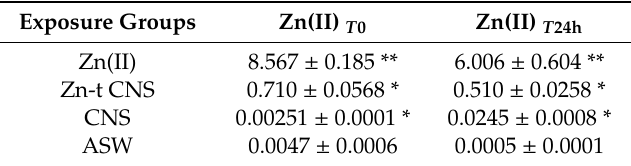
Table 1. Zn(II) concentration (mg L − 1 ) in mussels’ exposure waters at time zero ( T 0 ) (soon after preparation) and after 24 h ( T 24h ) of the following experimental groups: Zn(II) (ZnCl 2 10 mg L − 1 in ASW); Zn-t CNS (ZnCl 2 10 mg L − 1 contaminated ASW treated with CNS), CNS (ASW treated with CNS only); ASW (control). Results are reported as mean ± SD. (*) indicates significant di ff erences with respect to Zn(II) and (**) with respect to controls (ASW) ( p < 0.001). Exposure